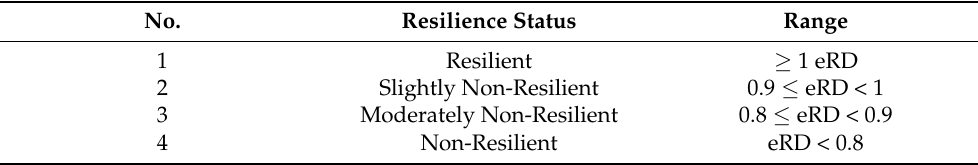
Table 1. Ecosystem resilience to drought using dimensionless ecosystem Resilience Index (eRd). No. Resilience